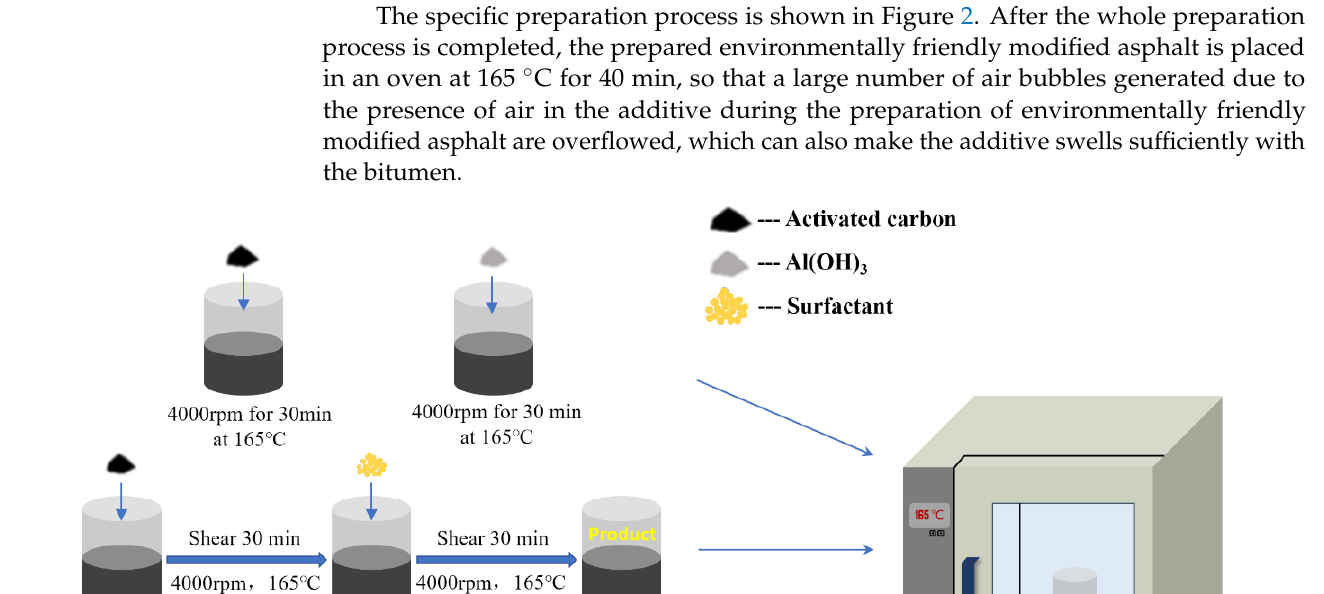
Figure 1. The schematics and properties of additives added for emission reduction.